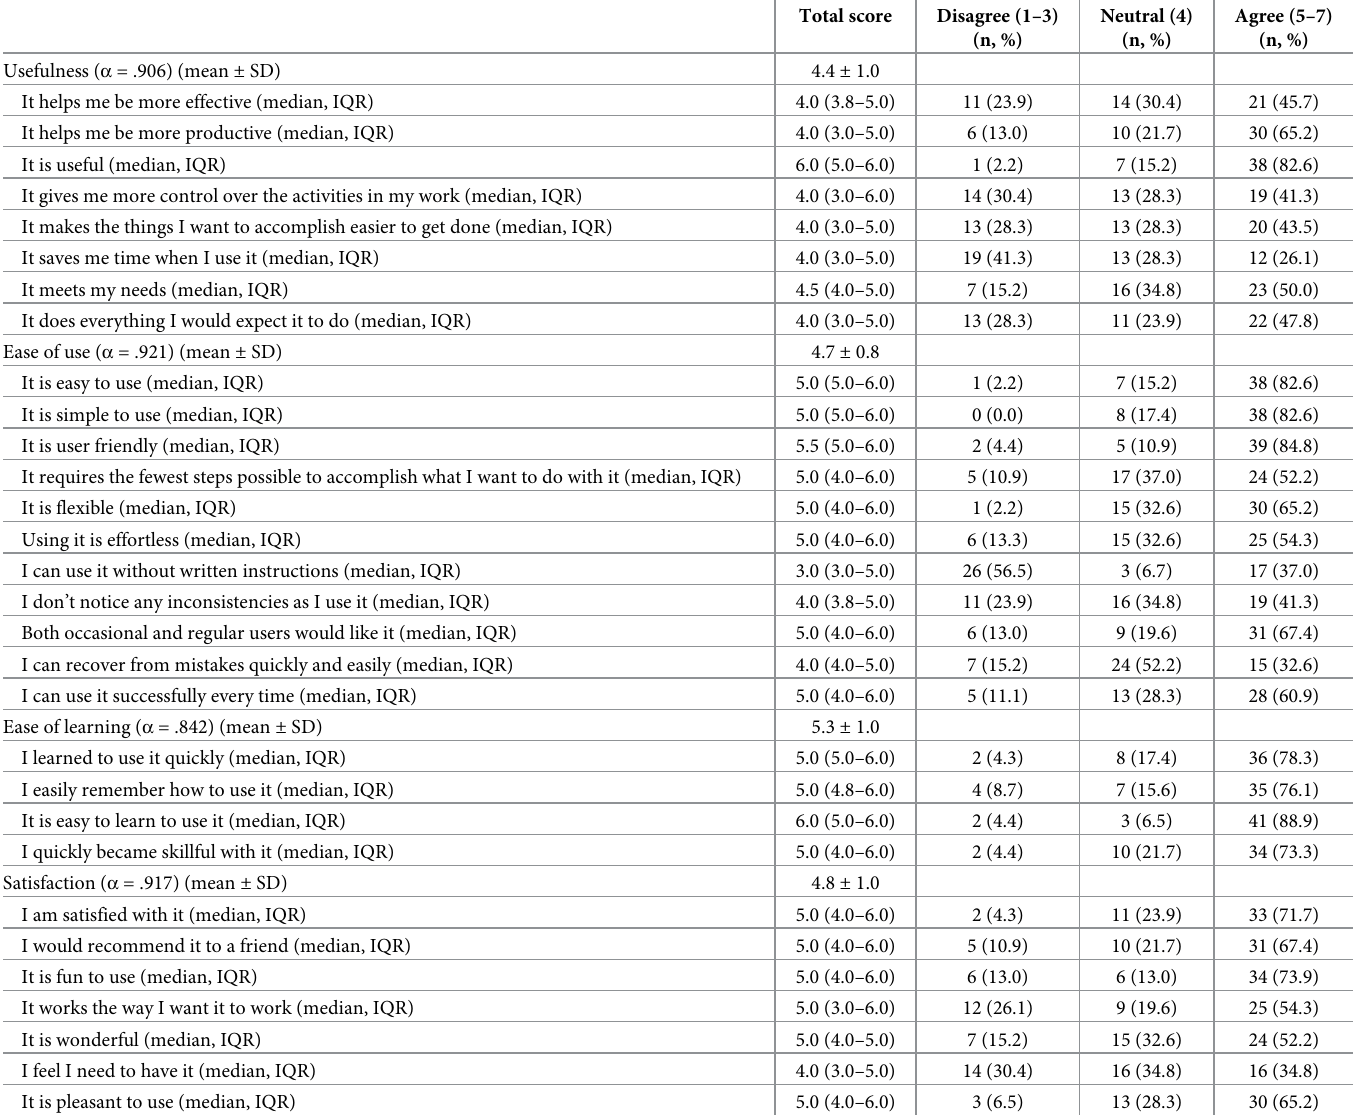
Table 3. Acceptability of healthcare professionals (n =